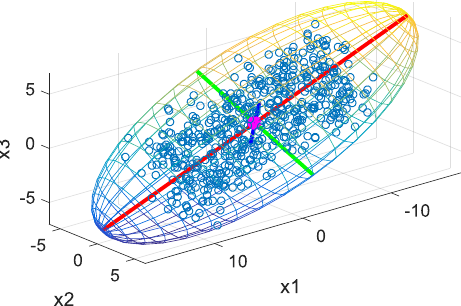
Figure 1. Illustration of principal components in a 3D point set.